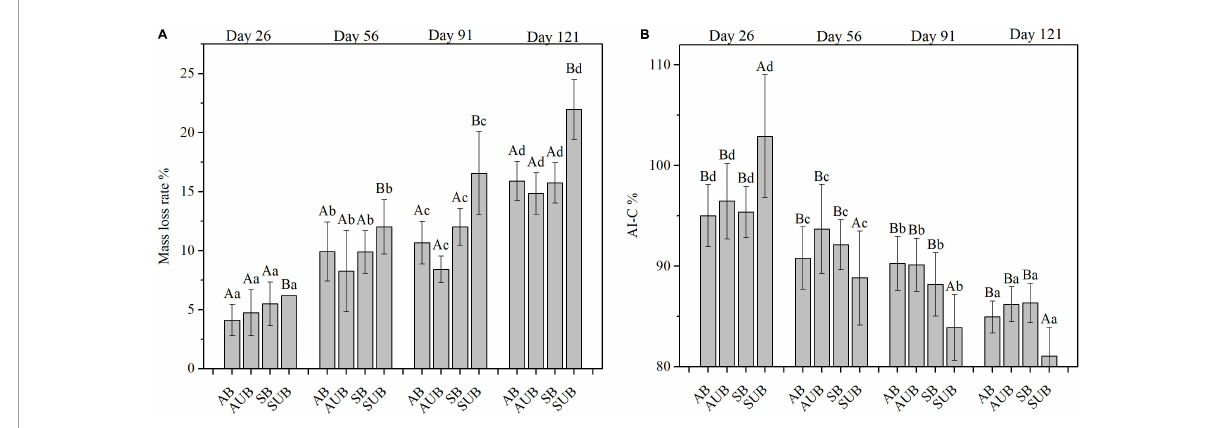
FIGURE2 Mass loss (A) and the AI-C (B) in residual plant litters in autumn burnt (AB), autumn unburnt (AUB), spring burnt (SB), and spring unburnt (SUB) sites. Different lowercase letters (a-d) indicate significant differences (Tukey-HSD test) among sampling times and different uppercase letters (A-B) indicate significant differences (Tukey-HSD test) between site types.